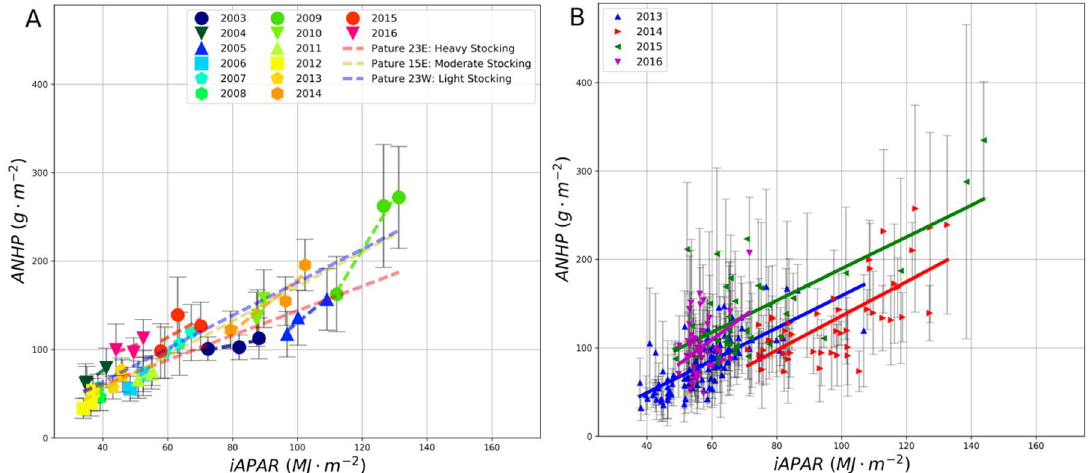
Figure 5. Spatial and temporal regressions of aboveground net herbaceous productivity (ANHP) on iAPAR for ( A ) the LTGI and ( B ) the CARM experiments. Error bars represent standard deviation in the measured ANHP. Slope, R 2 , and the number of observations for each model are shown in Table 1.